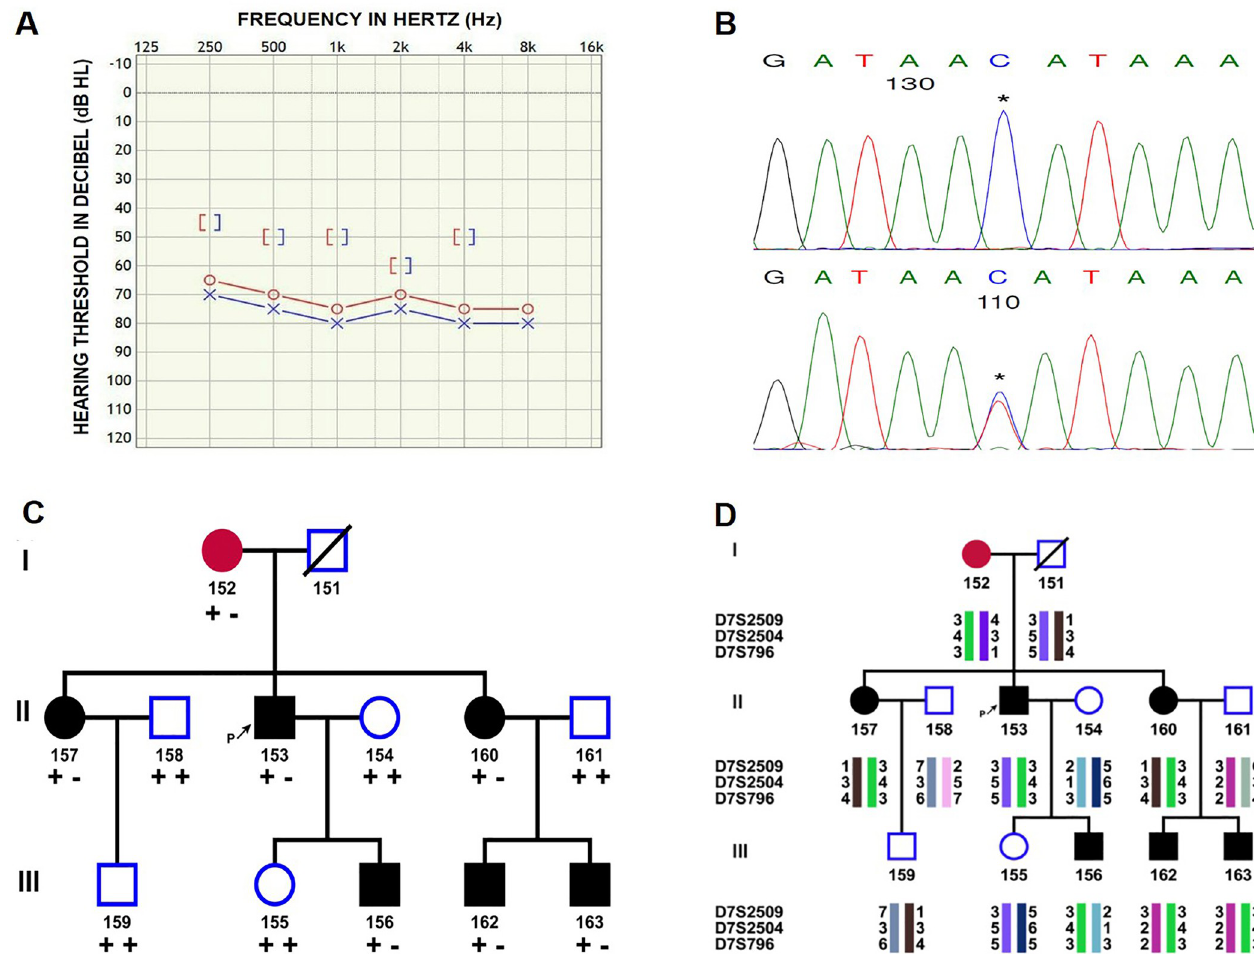
Fig 3. Transmission of disease associated alleles in OTSC family. (A)Typical audiogram of OTSC patient. On audiometric assessment, pure tone audiometry showed a bilateral severe mixed hearing loss in proband with an extent of severe hearing loss 71 dB in right ear and 75 dB in left ear. (B) Representative chromatograms showing the homozygous normal ‘C’ allele and heterozygous ‘CT’ genotype for rs74503667. (C) Inheritance of a rare variant rs74503667 in an OTSC family. Blackened squares and circles indicate affected males and females respectively. The + + and +— symbols indicate the normal and heterozygous genotypes for the variant. Individual identity was represented by the numbers and arrow indicates proband. (D) Pedigree showing the transmission of a linked haplotype (green) with the disease at RELN locus (7q22-22.1). Circle with red indicates individual with uncertain status.